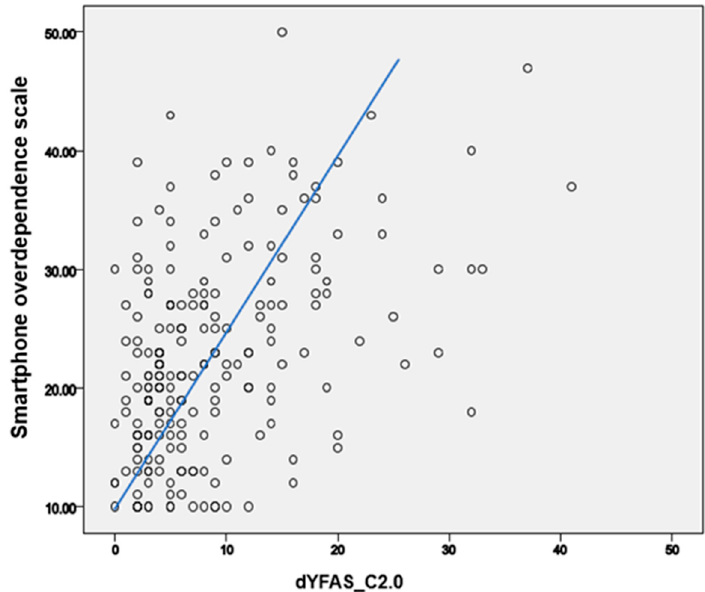
Figure 1. Correlation between food addiction and problematic smartphone use.